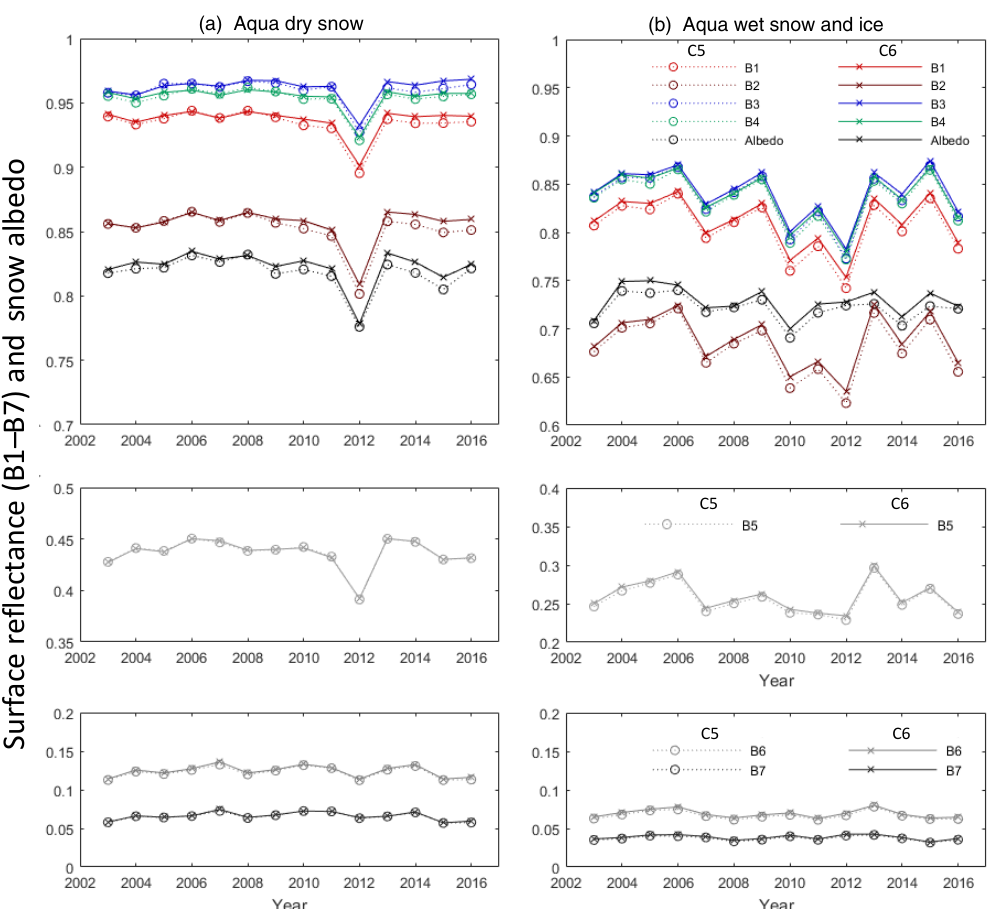
Figure 3. Aqua MODIS GrIS C5 (dashed) and C6 (solid) average annual 1 June–31 August MYD09A1 surface reflectance (B1–B7) and MYD10A1 (broadband snow albedo, denoted “albedo”) for dry (a) and wet snow and ice (b) . (Note the y -axis scale is different for dry vs. wet snow and ice for B1–4, albedo and